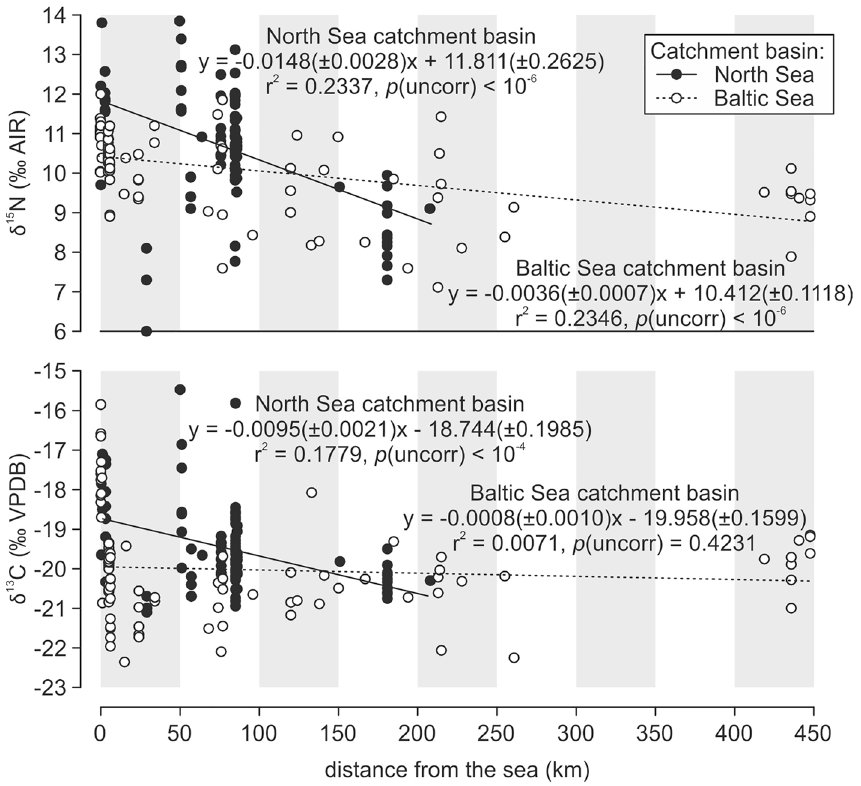
Figure 3. δ 13 C and δ 15 N values in cats vs. site distance from the